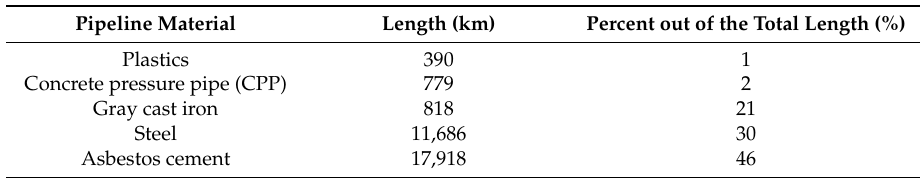
Table 2. Romanian water distribution pipelines